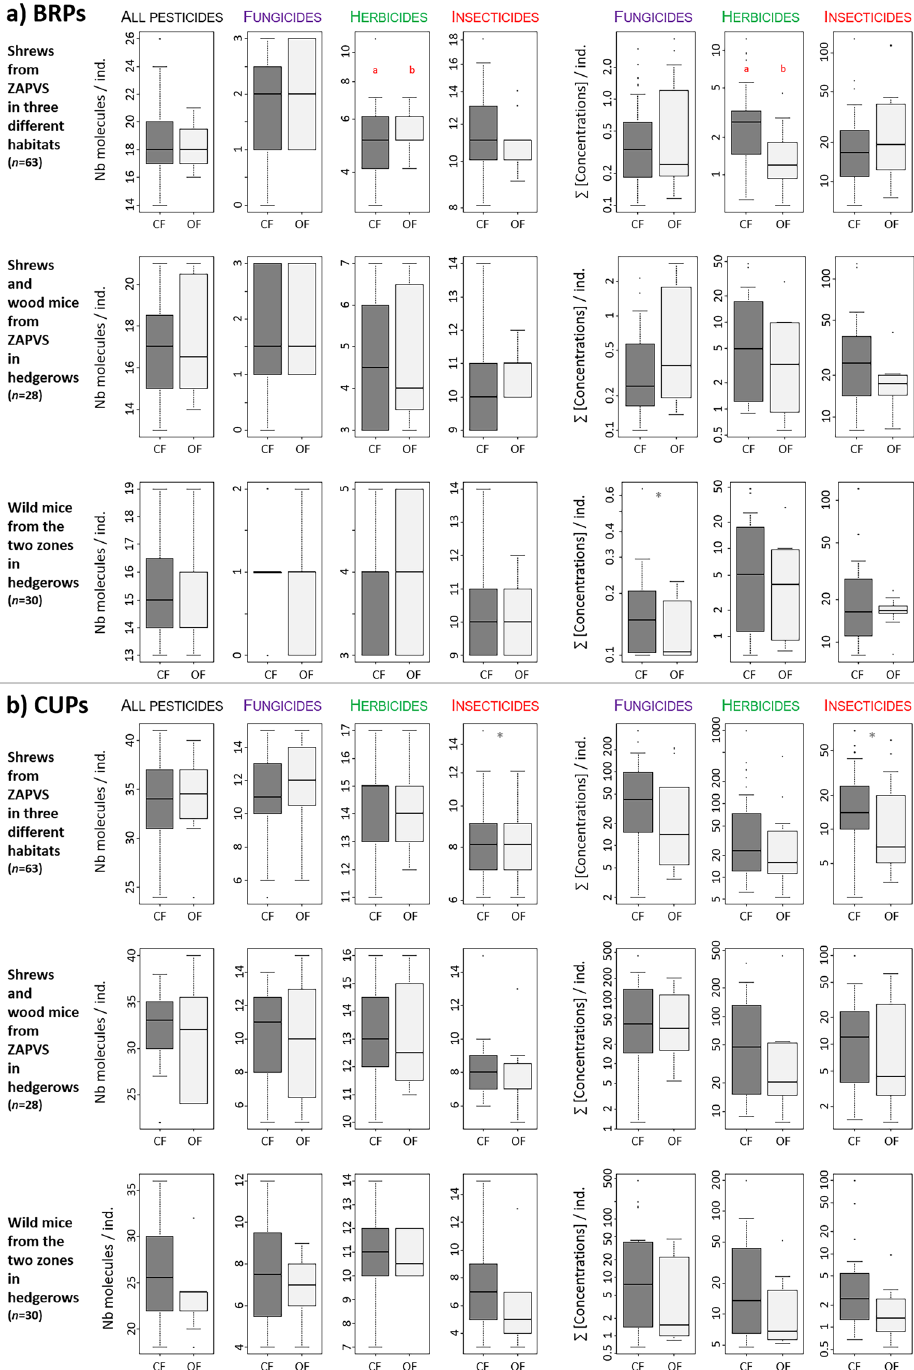
Figure 2. Boxplots of number of molecules and sum of concentrations for ( a ) banned and restricted pesticides (BRPs) and ( b ) currently used pesticides (CUPs) according to farming practices. Statistical differences between groups are indicated by red asterisks (statistical significance: p-value< 0.05), if close to significance level (0.10 > p-value > 0.05) the color of asterisk is grey. CF Conventional farming, OF Organic